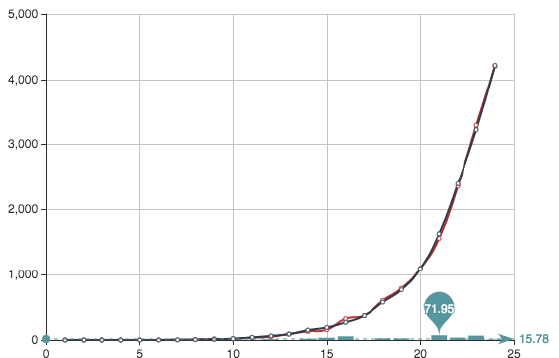
Figure 6. Joint representation of the data in E (red line) and its approximation for the restriction case sum < 1 (black line). The bar graph is the pointwise error with the maximum (red point) and the average (dashed line).